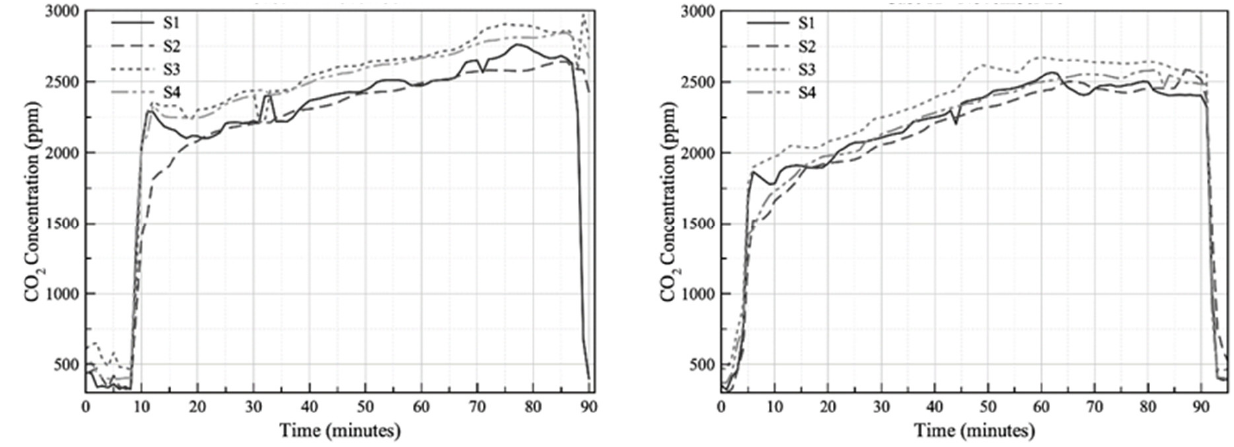
Figure 6. CO 2 concentration profile in two classrooms at Tecnologico de